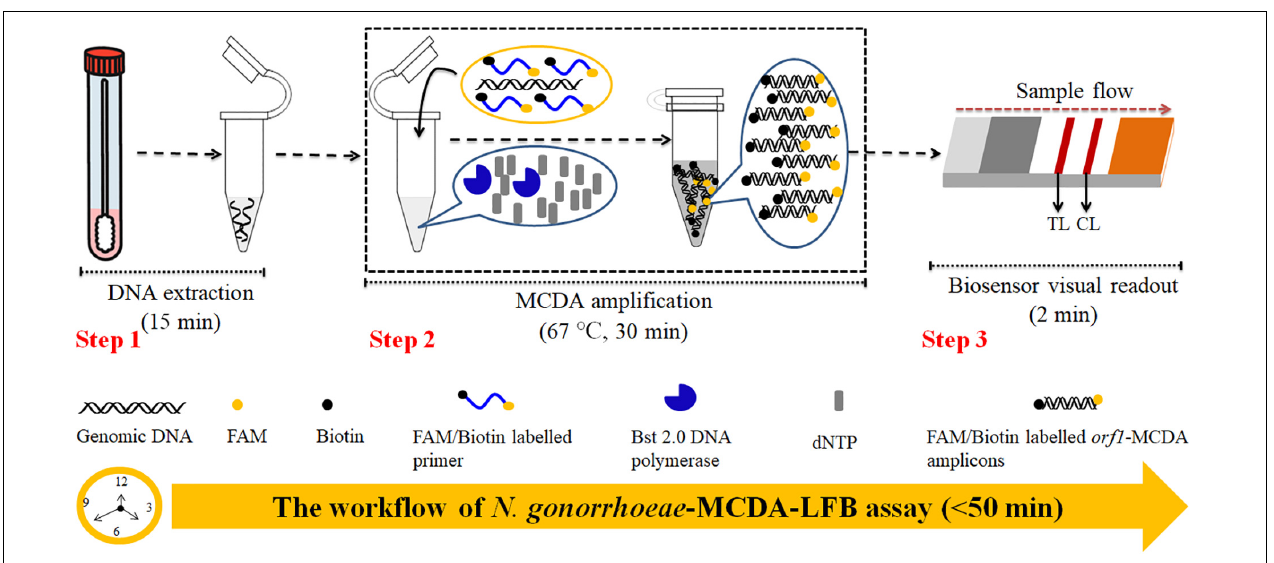
FIGURE 1 | Neisseria gonorrhoeae -multiple cross displacement amplification-lateral flow biosensor (MCDA-LFB) workflow. N. gonorrhoeae -MCDA-LFB assay uses three closely linked steps: DNA extraction (step 1), multiple cross displacement amplification (MCDA) (step 2), and gold nanoparticle-based lateral flow biosensor (LFB) readout (step 3). The detection process takes approximately 50 min.